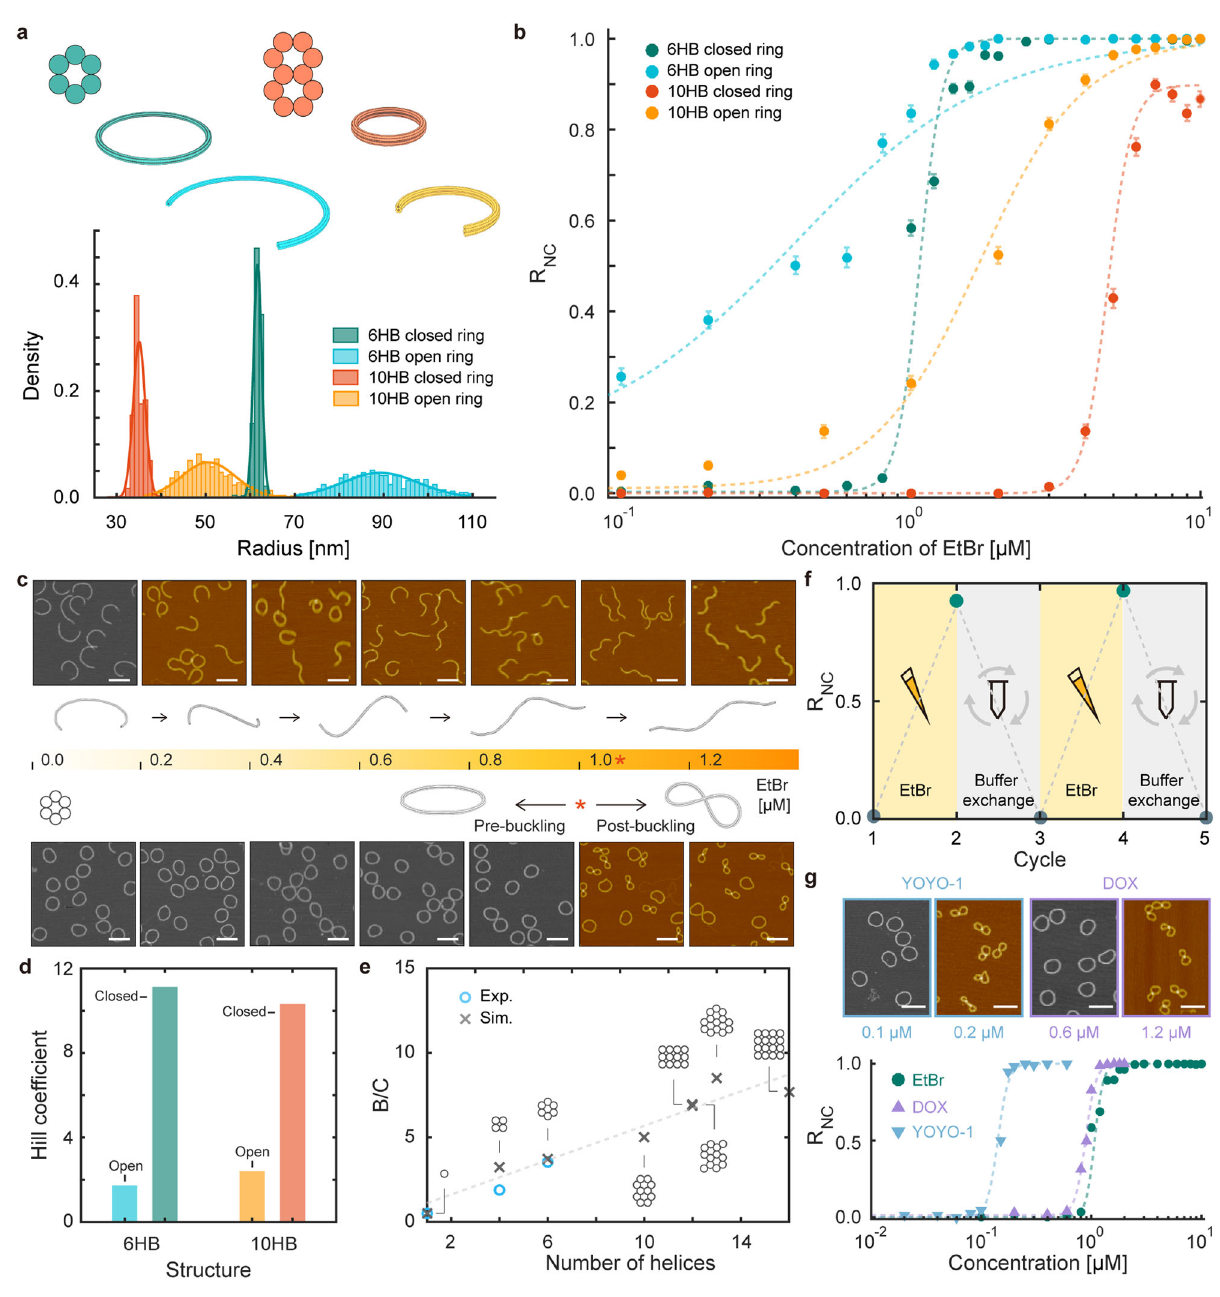
Fig. 2 Recon fi guration of open and closed DNA rings. a Schematics and histograms for experimentally measured radii of curvature for 6HB and 10HB rings. b Ratio of noncircular monomers (R NC ) as a function of EtBr concentration. Circles and error bars represent the mean and the standard deviation of experimentally measured R NC values, respectively. Dashed lines represent the fi tted Hill curves. c Representative AFM images and predicted con fi gurations (Supplementary Note 2) of 6HB open (top) and closed (bottom) rings. Scale bars in the AFM images represent 200 nm. d Effective Hill coef fi cients. e Ratio of bending rigidity to torsional rigidity (B/C) of DNA bundles with various cross-sectional shapes. Blue circles and black crosses represent experimental 32,55 and predicted values, respectively. The dashed line shows a linear fi t to the predicted B/C values. f Reversibility of ultrasensitive recon fi guration. g Ultrasensitive threshold recon fi guration of 6HB closed rings by DOX and YOYO-1. Markers and error bars represent the mean and the standard deviation of experimentally measured R NC values, respectively. Dashed lines represent the fi tted Hill curves. Scale bars in the AFM images represent 200